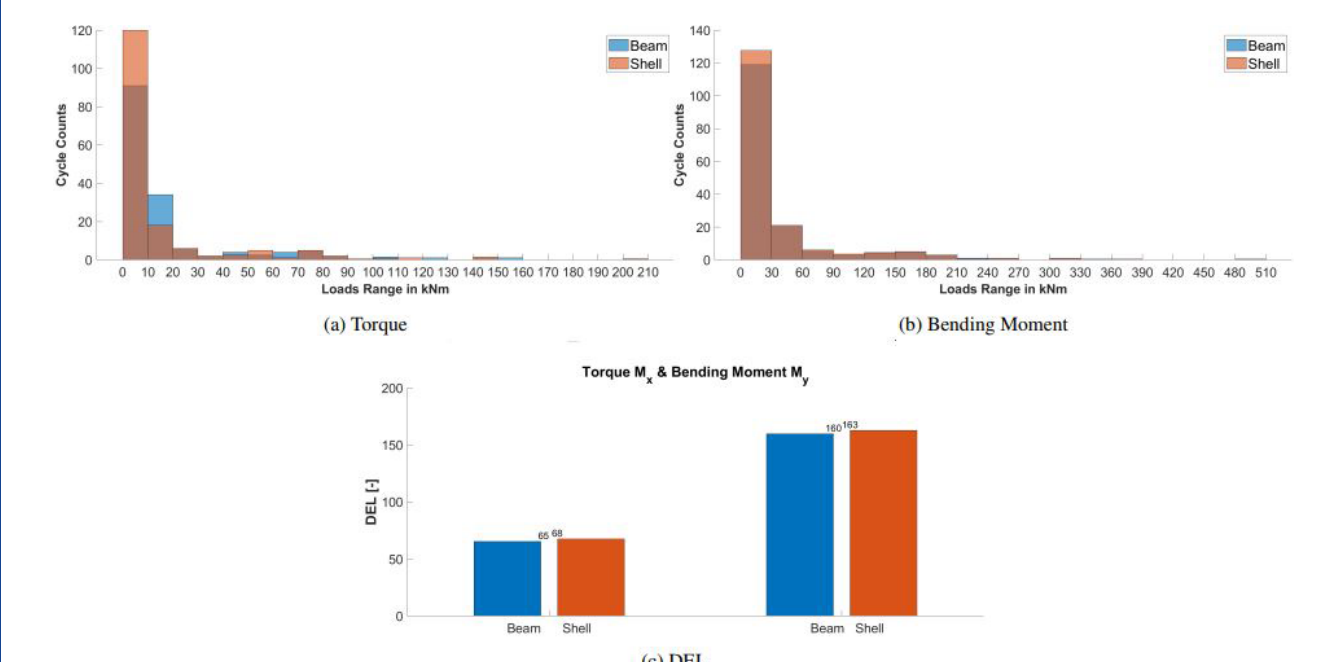
Figure 15. Cycle count using the torque (a) and bending moment (b) and resulting DEL (c) . Comparison of beam and shell model by